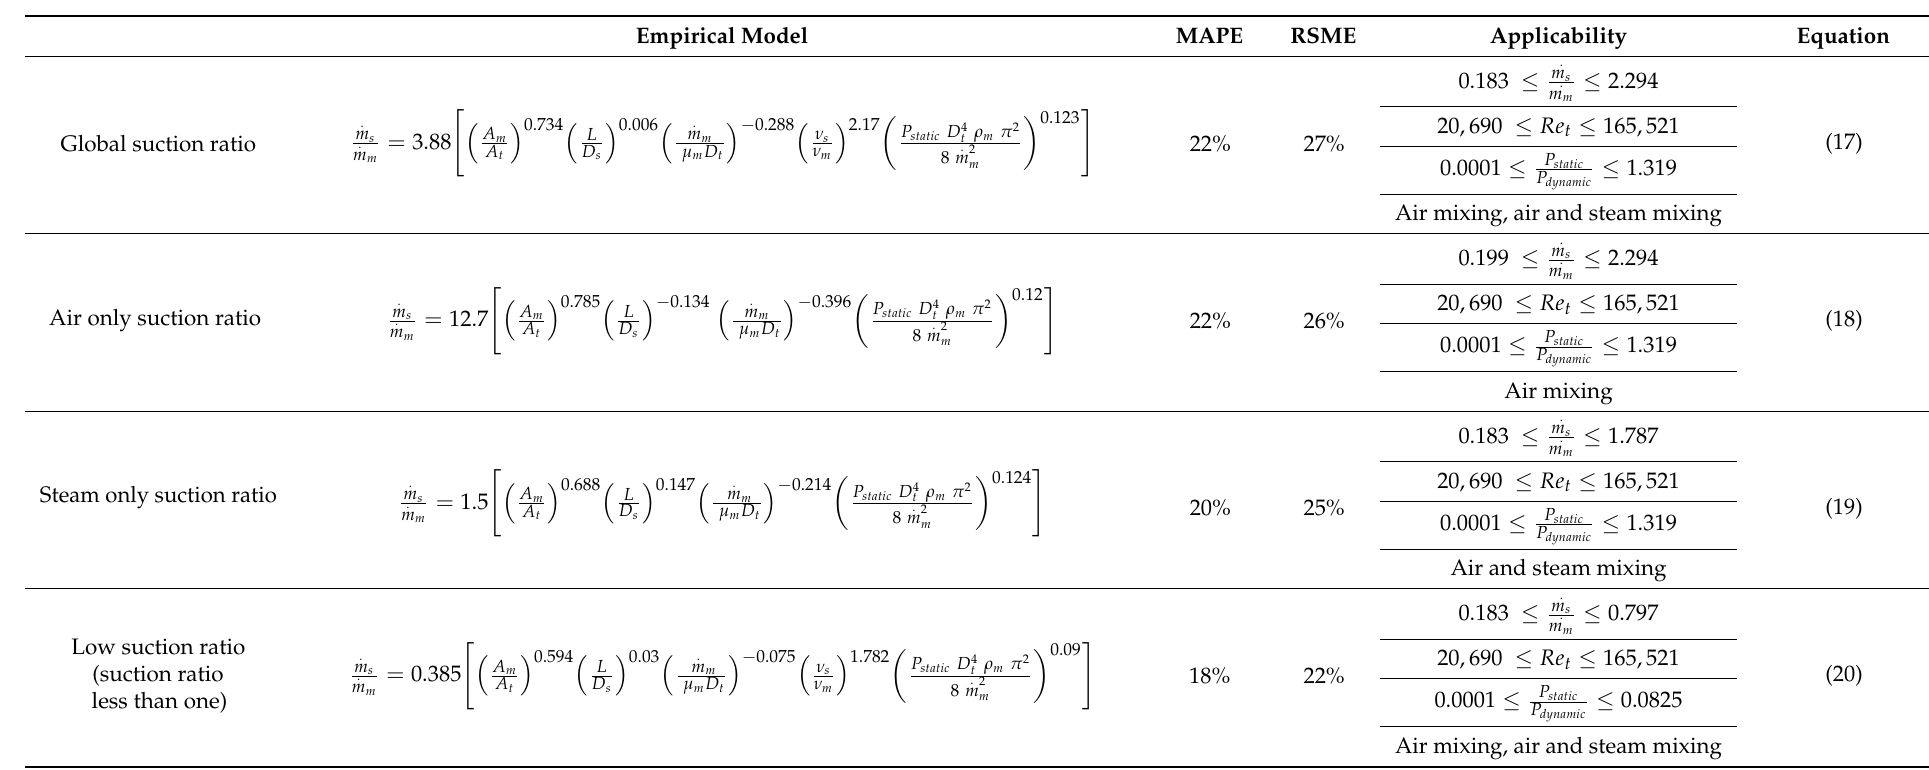
Table 5. Summary of proposed empirical models, ranges of applicability, mean absolute percentage error (MAPE), and root mean square error